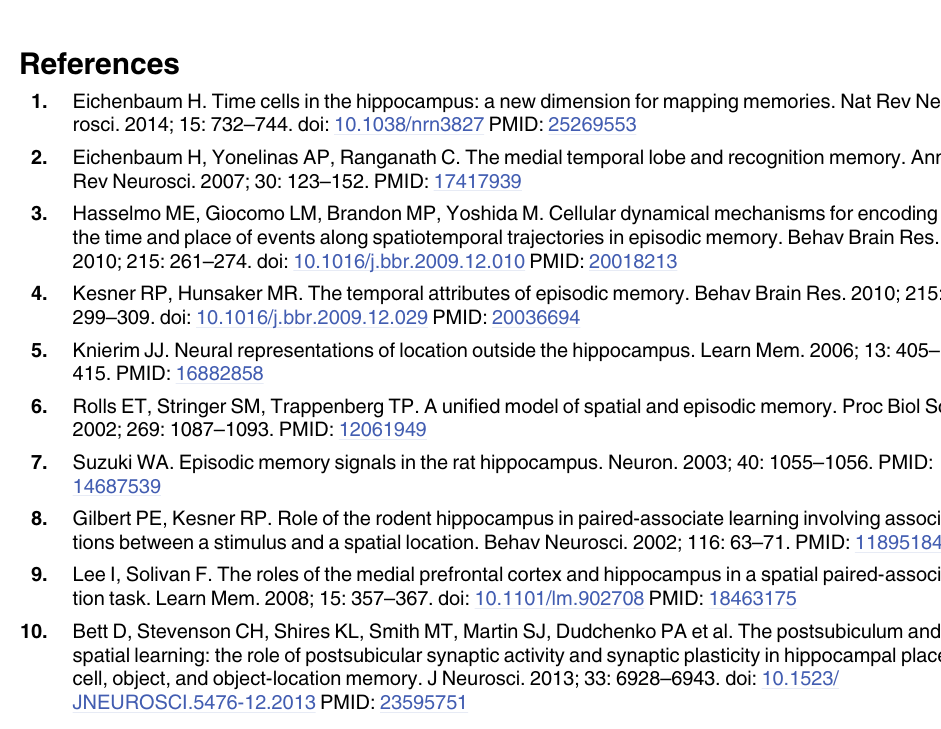
S1 Table. The mean and standard error for measures reported in Fig 2. S2 Table. The mean and standard error for the percentage of target object selection reported in Fig 3. S3 Table. The mean and standard error for measures reported in Fig 4. S4 Table. The mean and standard error for the percentage of target object selection reported in Fig